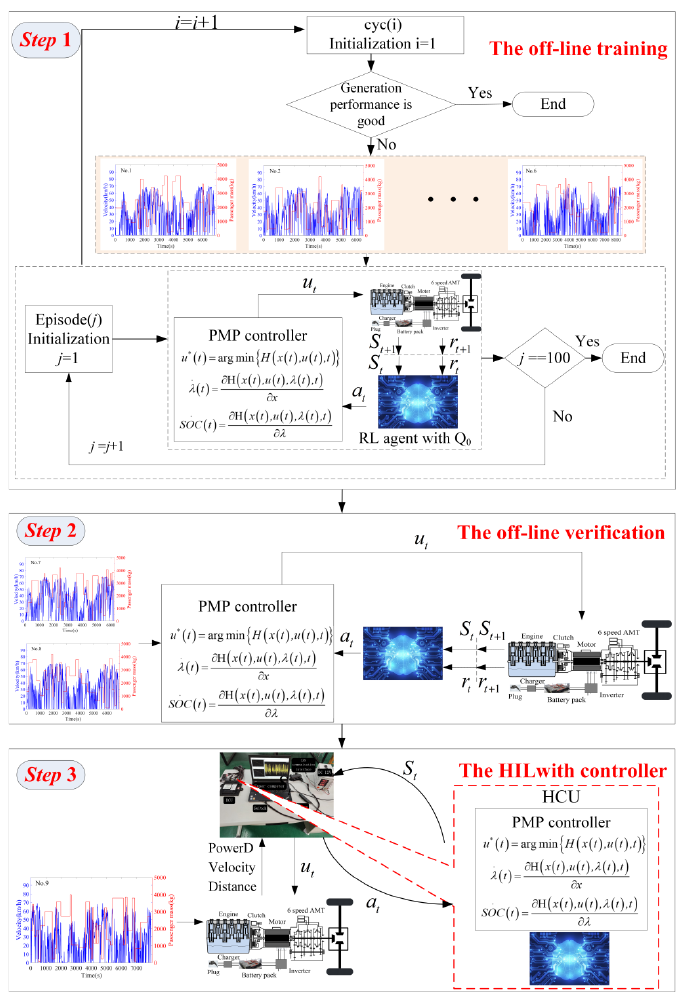
Figure 8. The design process of the RL-based energy management.